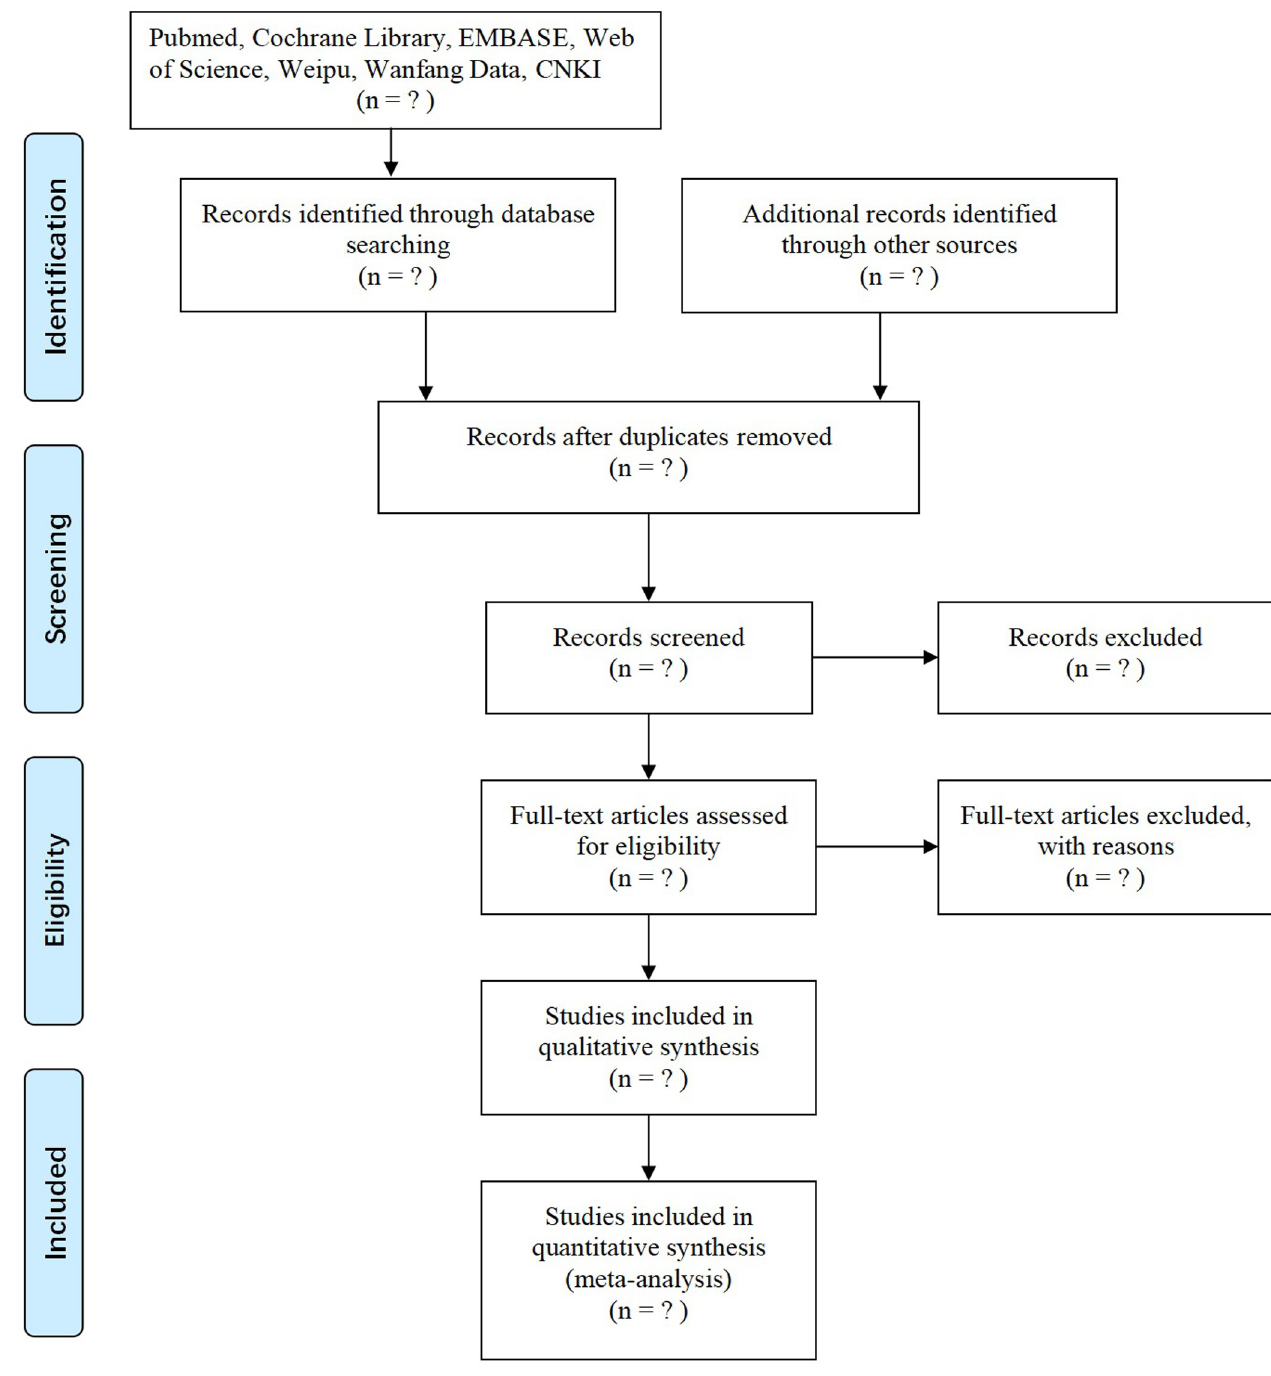
Fig 1. Flow diagram of the study selection